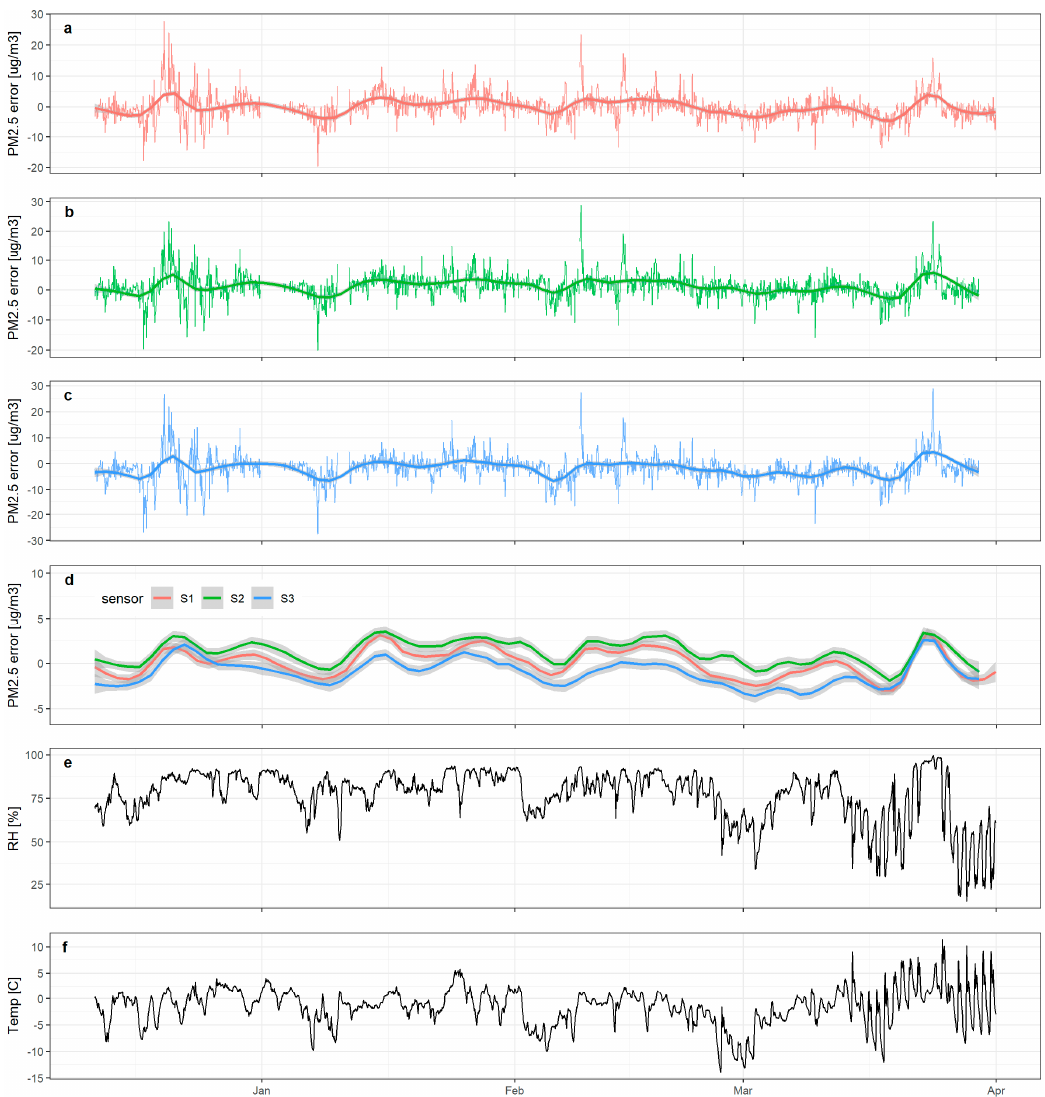
Figure 5. Evolution of sensor error (expressed as hourly sensor observation of PM 2.5 minus the hourly PM 2.5 observation at the station) over time: Panels ( a ), ( b ) and ( c ) show the hourly sensor error (thin line) and a Loess fit to the same data to highlight the overall temporal variability (thick line) for sensor units S1 through S3, respectively. Panel ( d ) shows a direct inter-comparison of the Loess fits of all three sensors units. Panels ( e ) and ( f ) show the relative humidity and temperature, respectively.